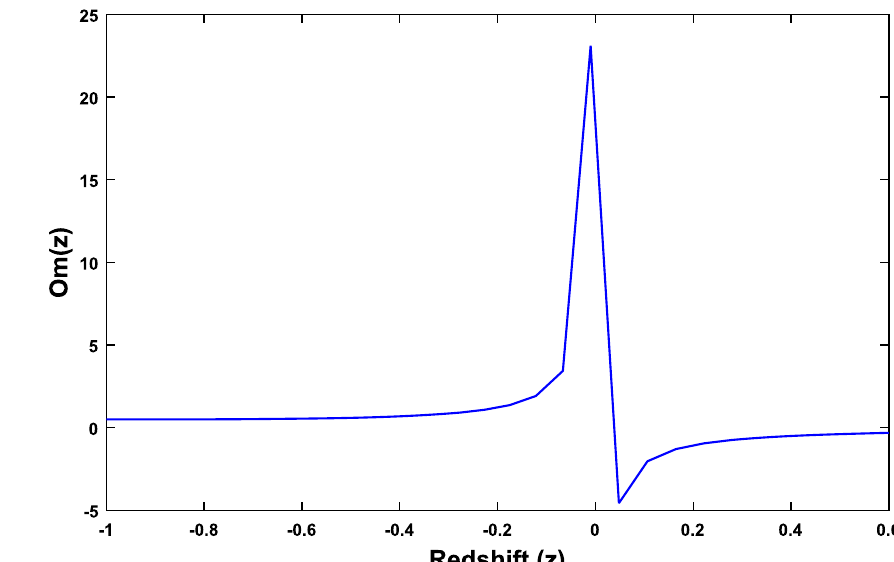
Fig. 18 Plot of Om versus redshift ( z ) for c 1 = 0 . 01, c 2 = 0 . 115, k = 0 . 325, γ = 2 . 13, and H 0